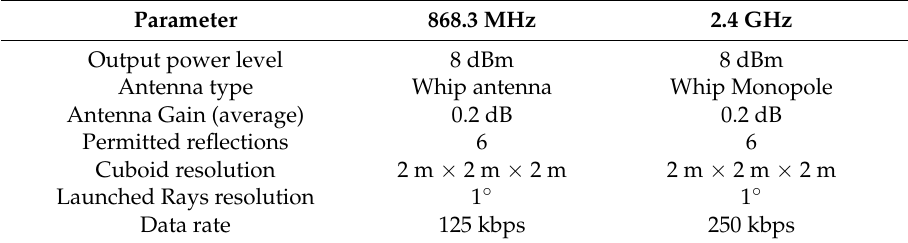
Figure 6. Linear path RF power distribution, corresponding to the white dashed line of Figure 5. ( a ) First floor height; ( b ) Second floor height; ( c ) Third floor height. Table 1. 3D Ray Launching simulation parameters.